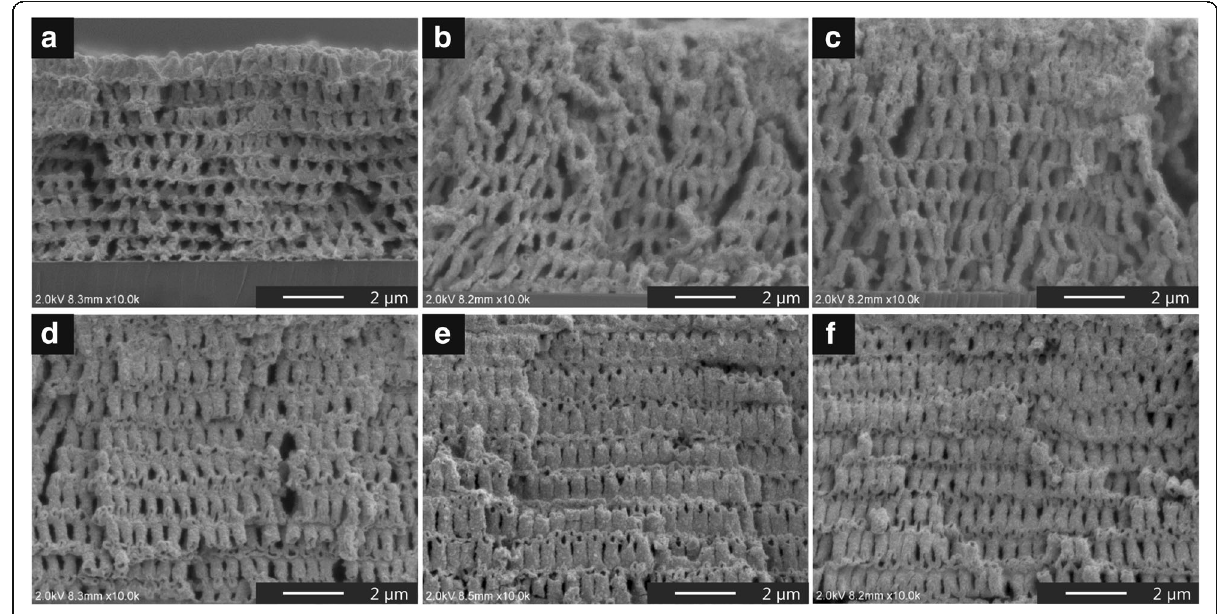
Fig. 3 Cross-sectional SEM images of the resultant 3D inverse structures after post-baking . The infiltration process was conducted with different cycle numbers from one to six ( a – f